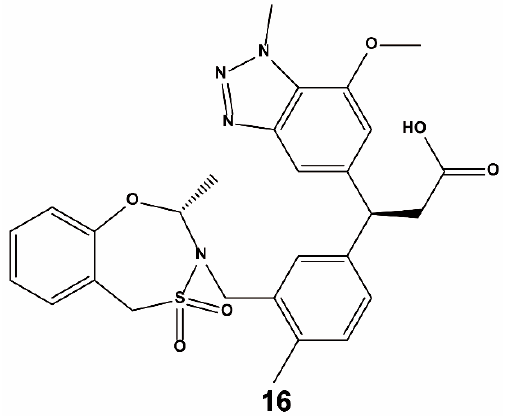
Figure 10. Structure of compound 16 .